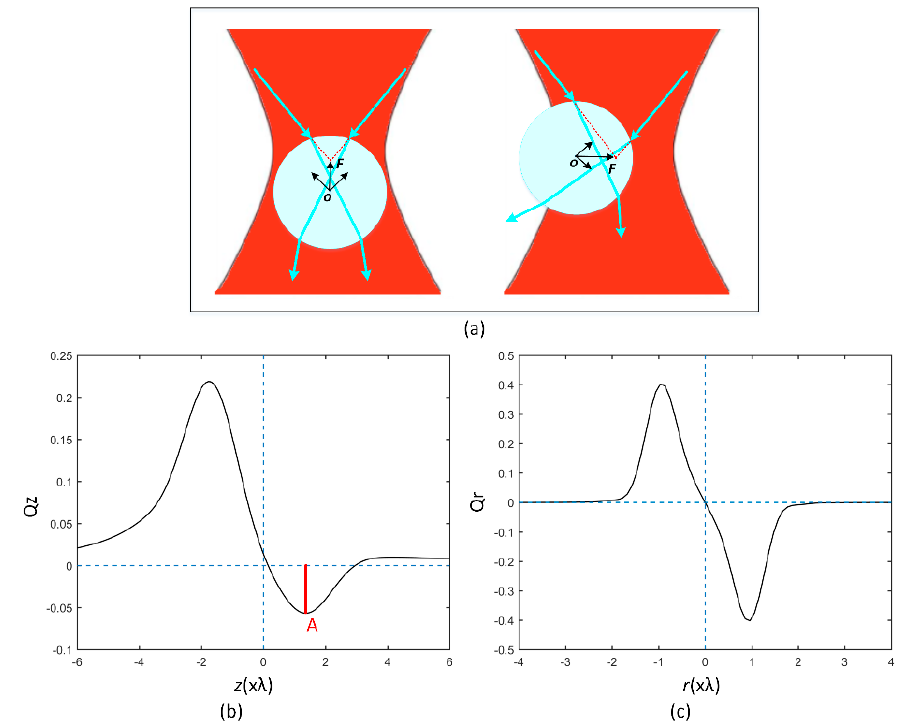
Figure 1. Force on a polystyrene (PS) sphere in a Gaussian beam trap. The PS sphere has a radius of 1 λ , and has a relative refractive index of n rel = 1.59/1.33 = 1.20, trapped at 1064 nm, using an objective with numerical aperture of 1.02. ( a ) A scheme of optical trapping, in which the sphere in a focused Gaussian beam is dragged toward a region of high intensity. ( b ) The axial trapping e ffi ciency as a function of axial displacement and ( c ) the transverse trapping e ffi ciency as a function of transverse displacement from the equilibrium point. The maximum reverse axial force A is shown in ( b ) and it characterizes the strength of the trap.